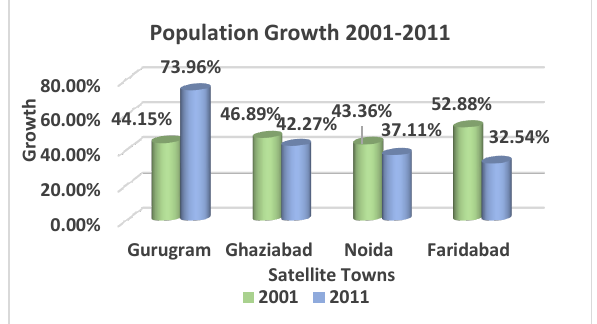
Figure 2.Decadal growth of population